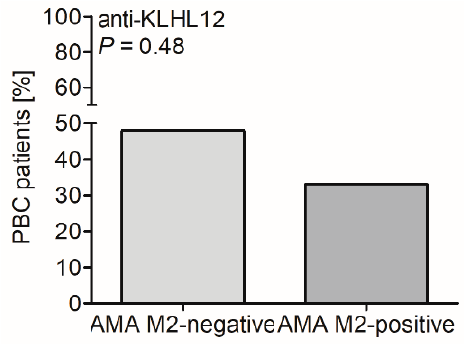
Figure 6. Prevalence of anti-KLHL12 antibodies in the AMA M2-positive and AMA M2-negative PBC cohorts.